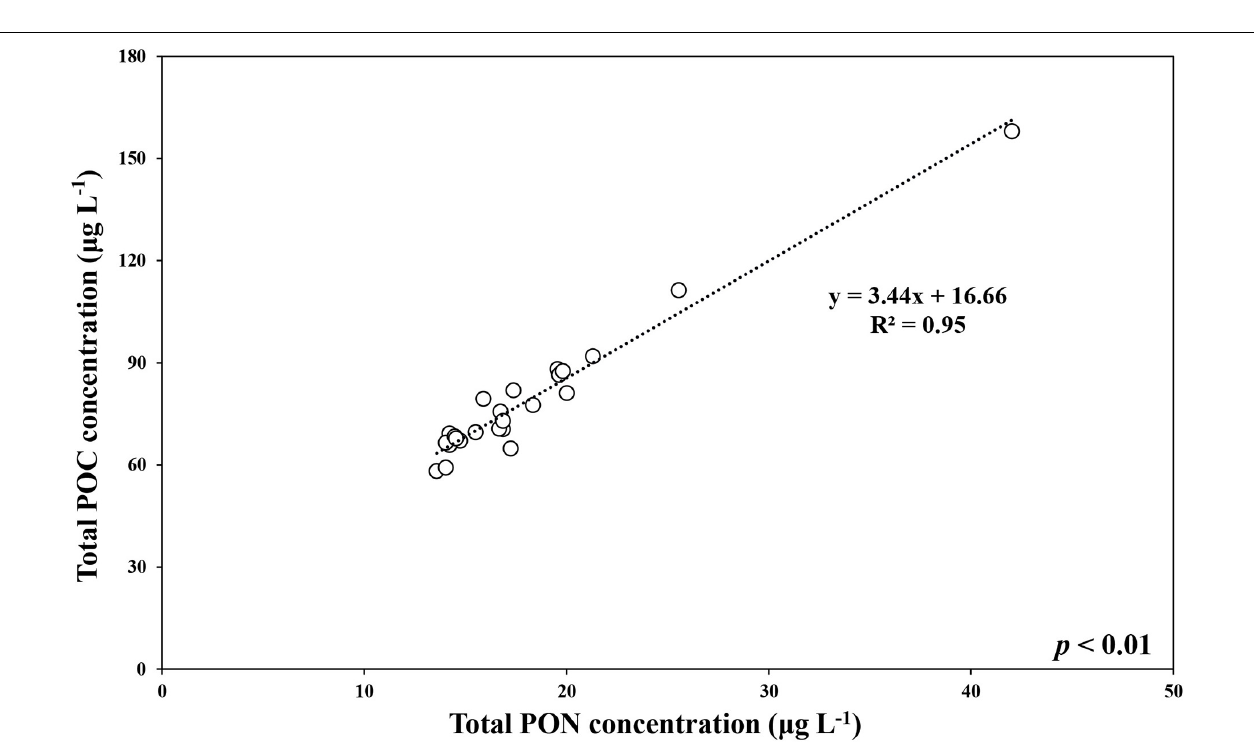
Frontiers in Microbiology |